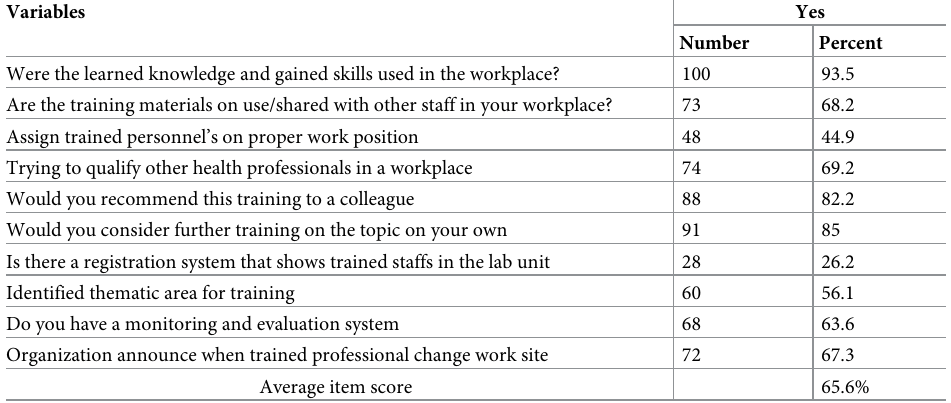
Table 6. Trainees knowledge and skill transfer into practice in their working facility, northeast Ethiopia, Octo- ber/2019 (N = 107). Variables Yes